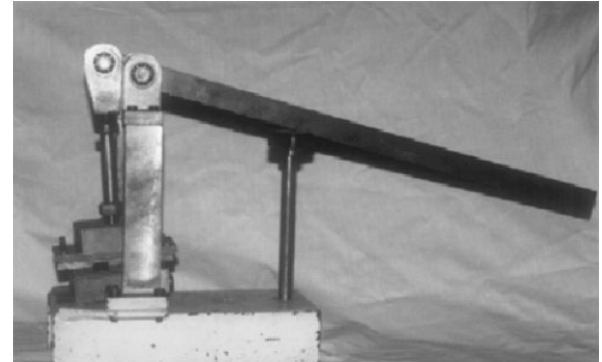
Figure 4 Lever equipment for the